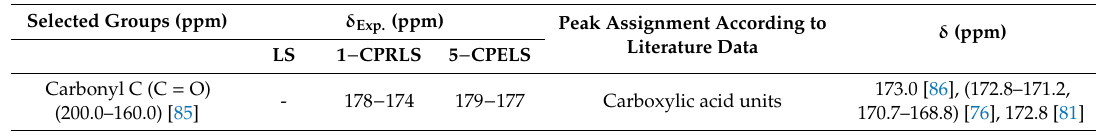
Figure 3. 13 C-NMR spectra of LS, 1-CPRLS, and 5-CPELS in DMSO-d 6 solutions at 50 ˚ C. Table 1. Structural assignments in 13 C-NMR spectra of LS, 1-CPRLS, and 5-CPELS in DMSO-d 6 solutions based on the spectra in Figure 3.